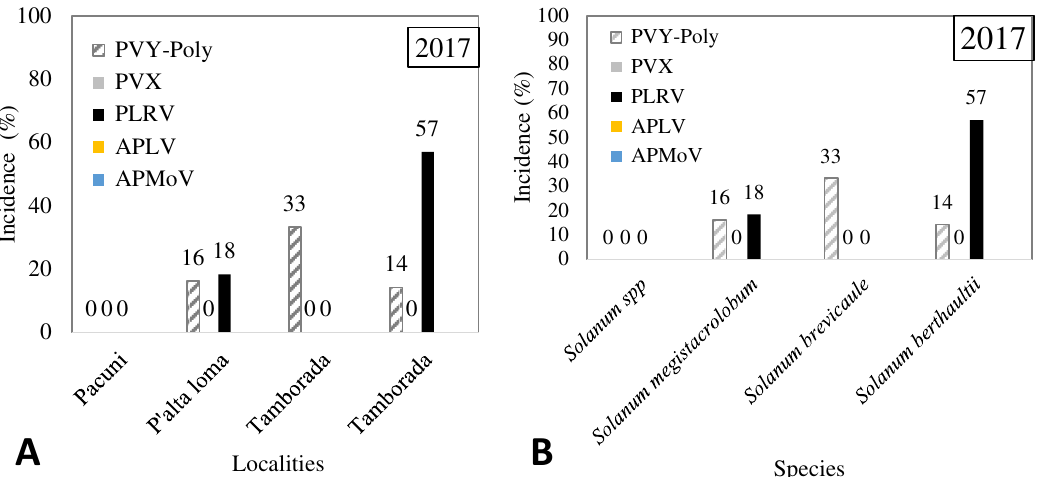
Figure 3. Viruses’ incidence on potato wild relatives in the Andean region of Bolivia. A: 2017,